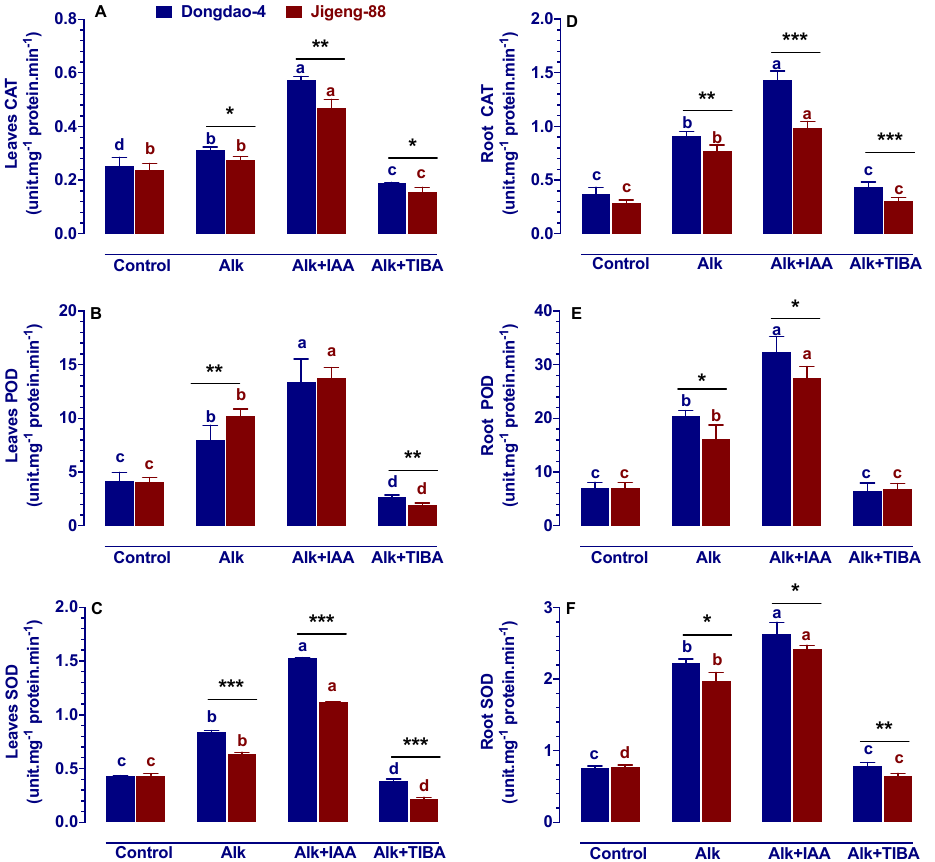
Figure 6. Effects of IAA and TIBA on antioxidant enzymes in shoots/roots of Dongdao-4 and Jigeng-88 seedlings after treatment with alkaline stress. ( A , D ) Catalase (CAT) in leaves/roots. ( B , E ) Peroxidase (POD) in leaves/roots. ( C , F ) Superoxide dismutase (SOD) leaves/roots. Treatments were as described in Figure 1. Means with different letters are significantly different ( p < 0.05) between control and “Alk” and “Alk + IAA” and “Alk + TIBA” of the same genotype. Asterisks indicate significant differences between different genotypes within the same treatment (* p < 0.05, ** p < 0.01, *** p < 0.001).